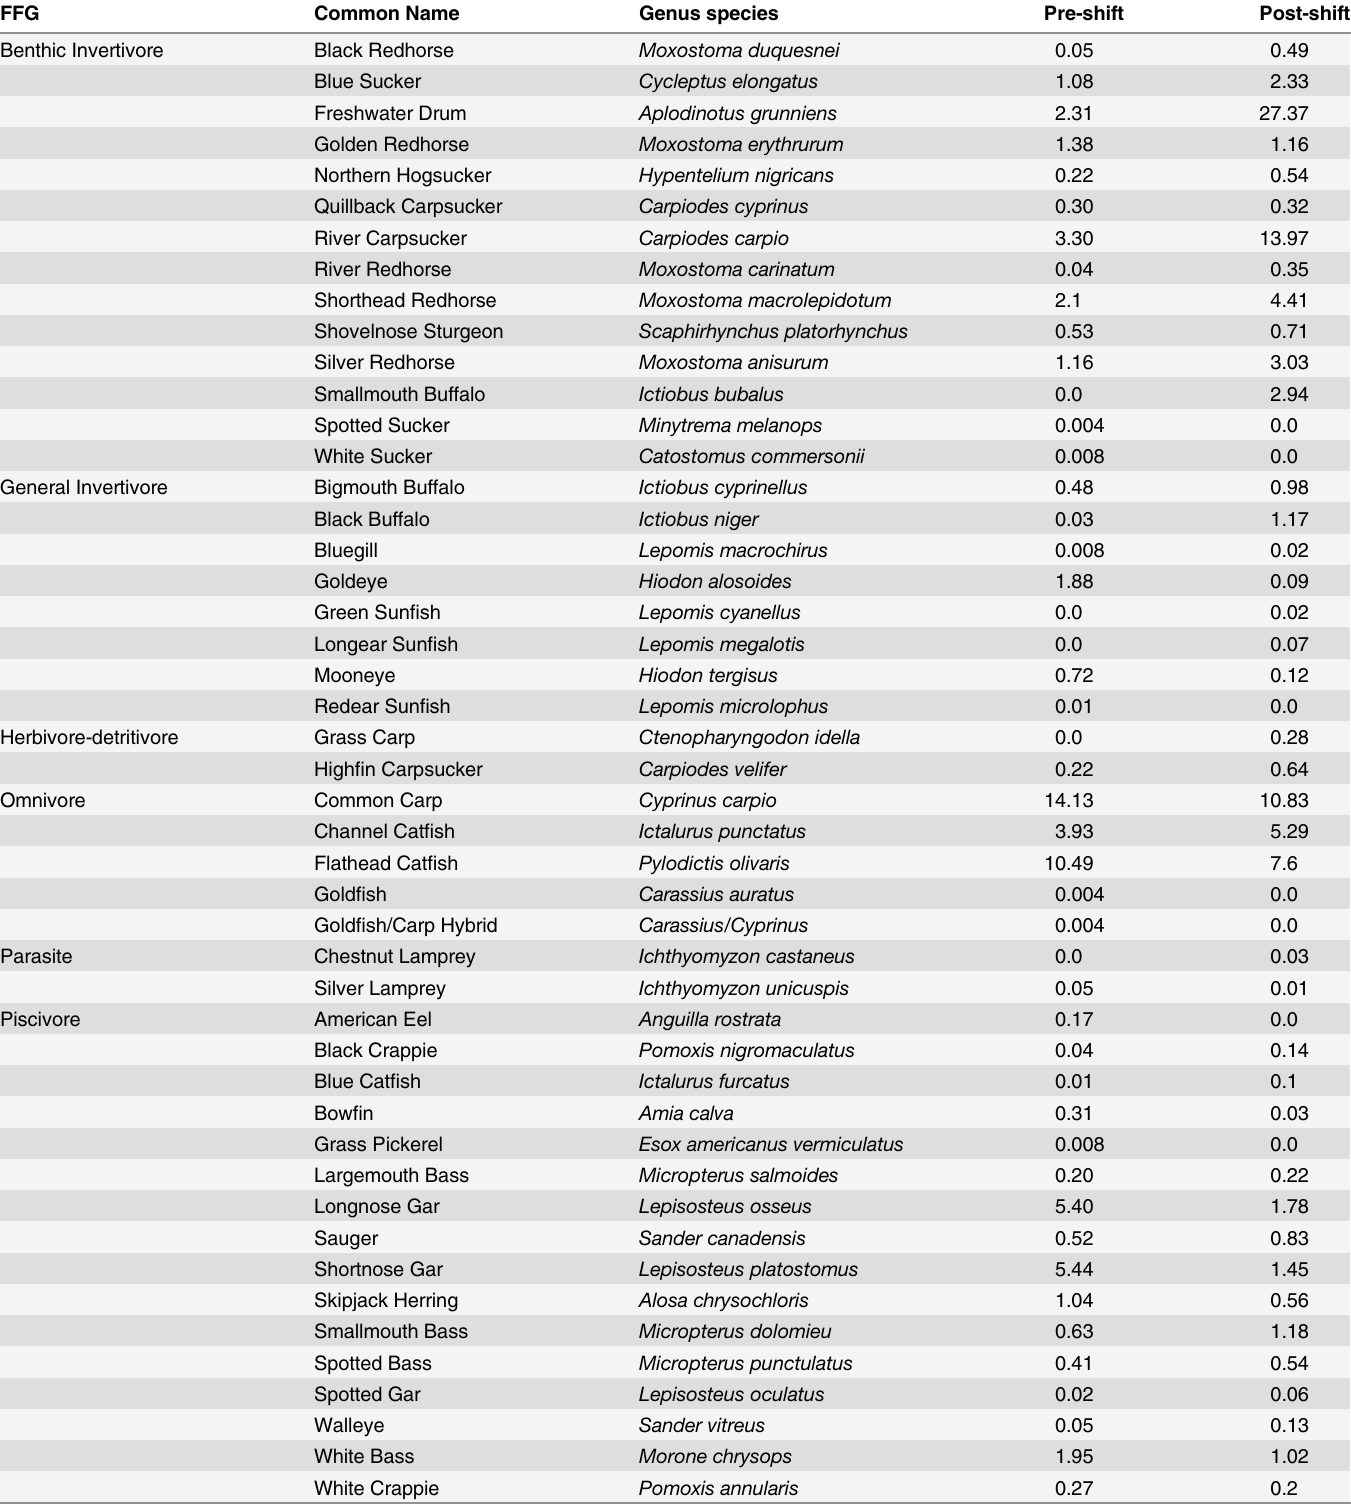
Table 1. Species assignments to functional feeding groups and percent abundance before and after assemblage shift in 1992.